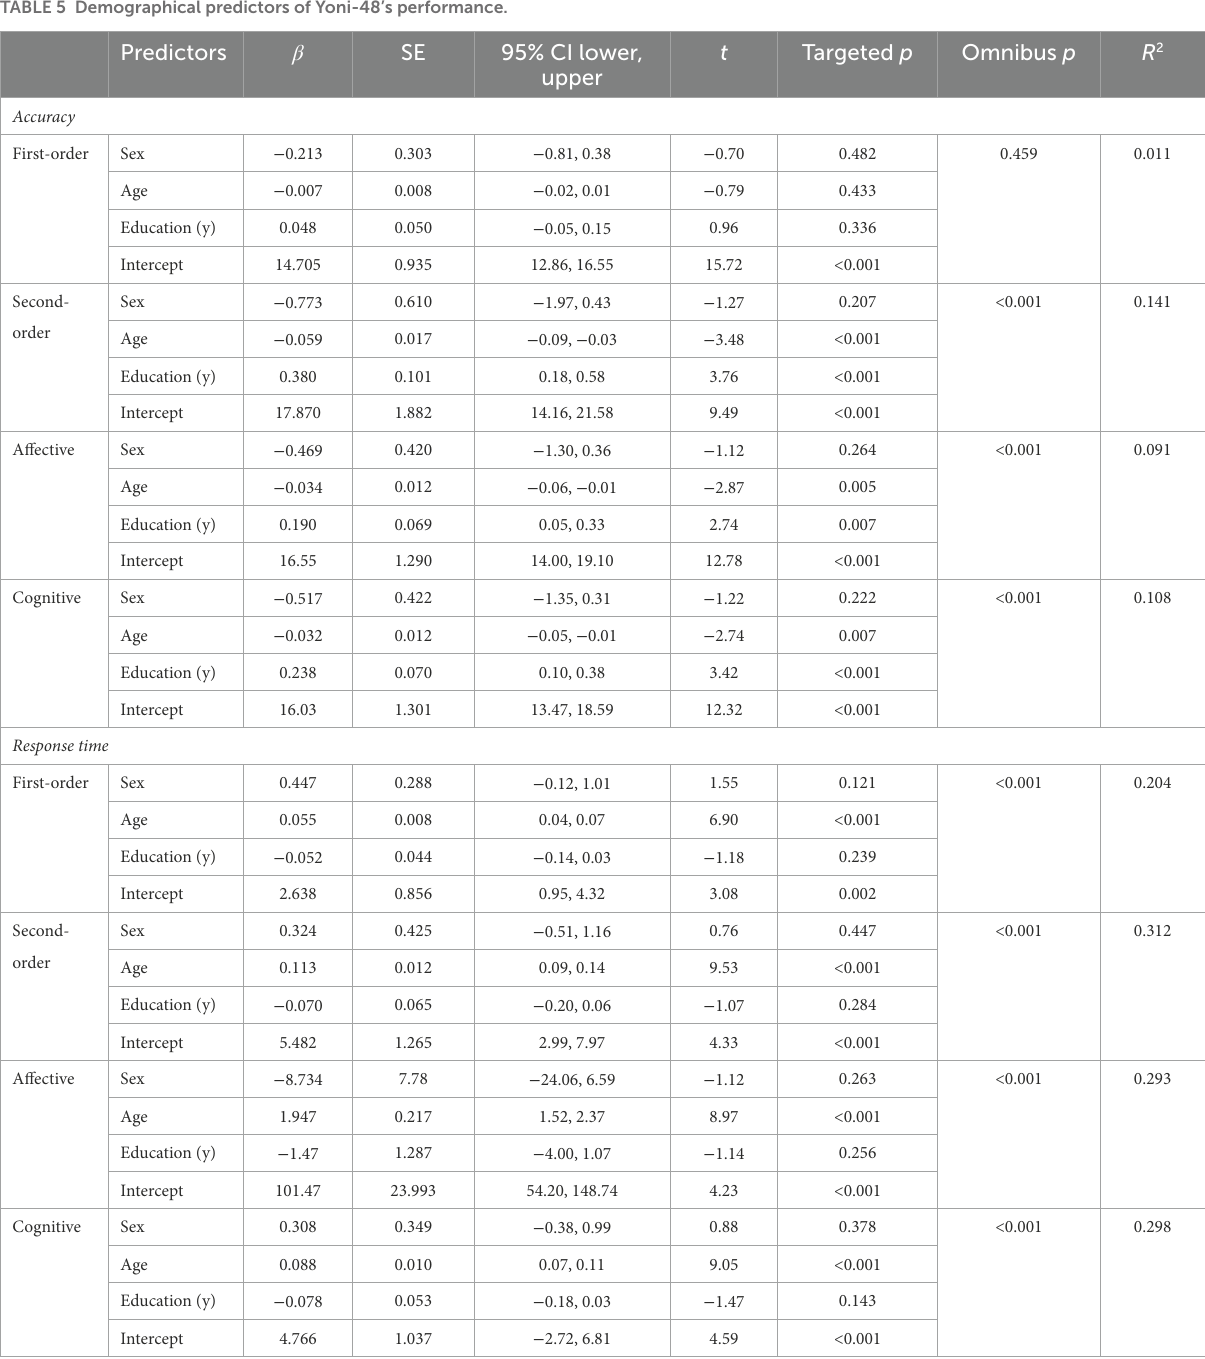
TABLE 5 Demographical predictors of Yoni-48’s